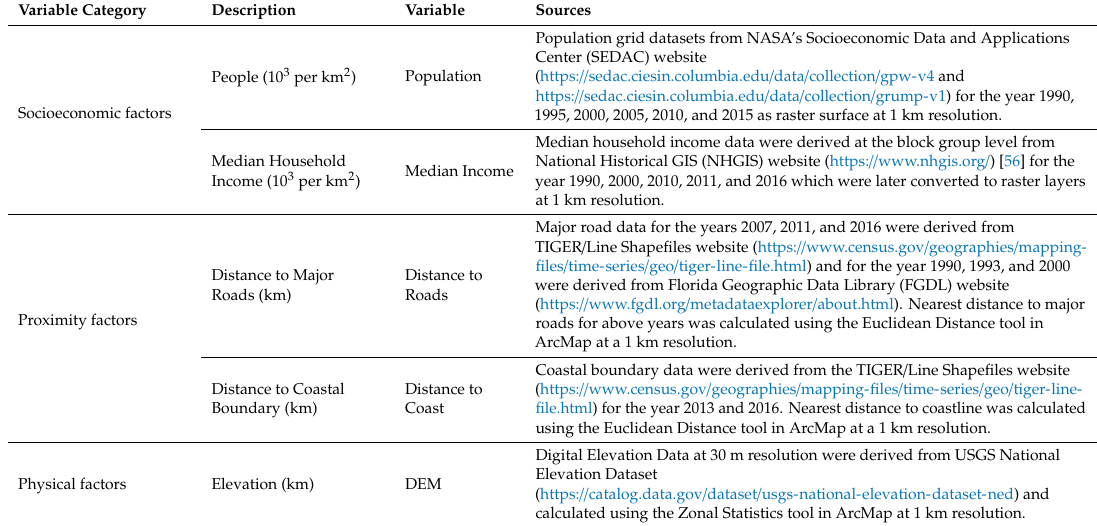
Table 2. Selected variables of major explanatory factors of urban